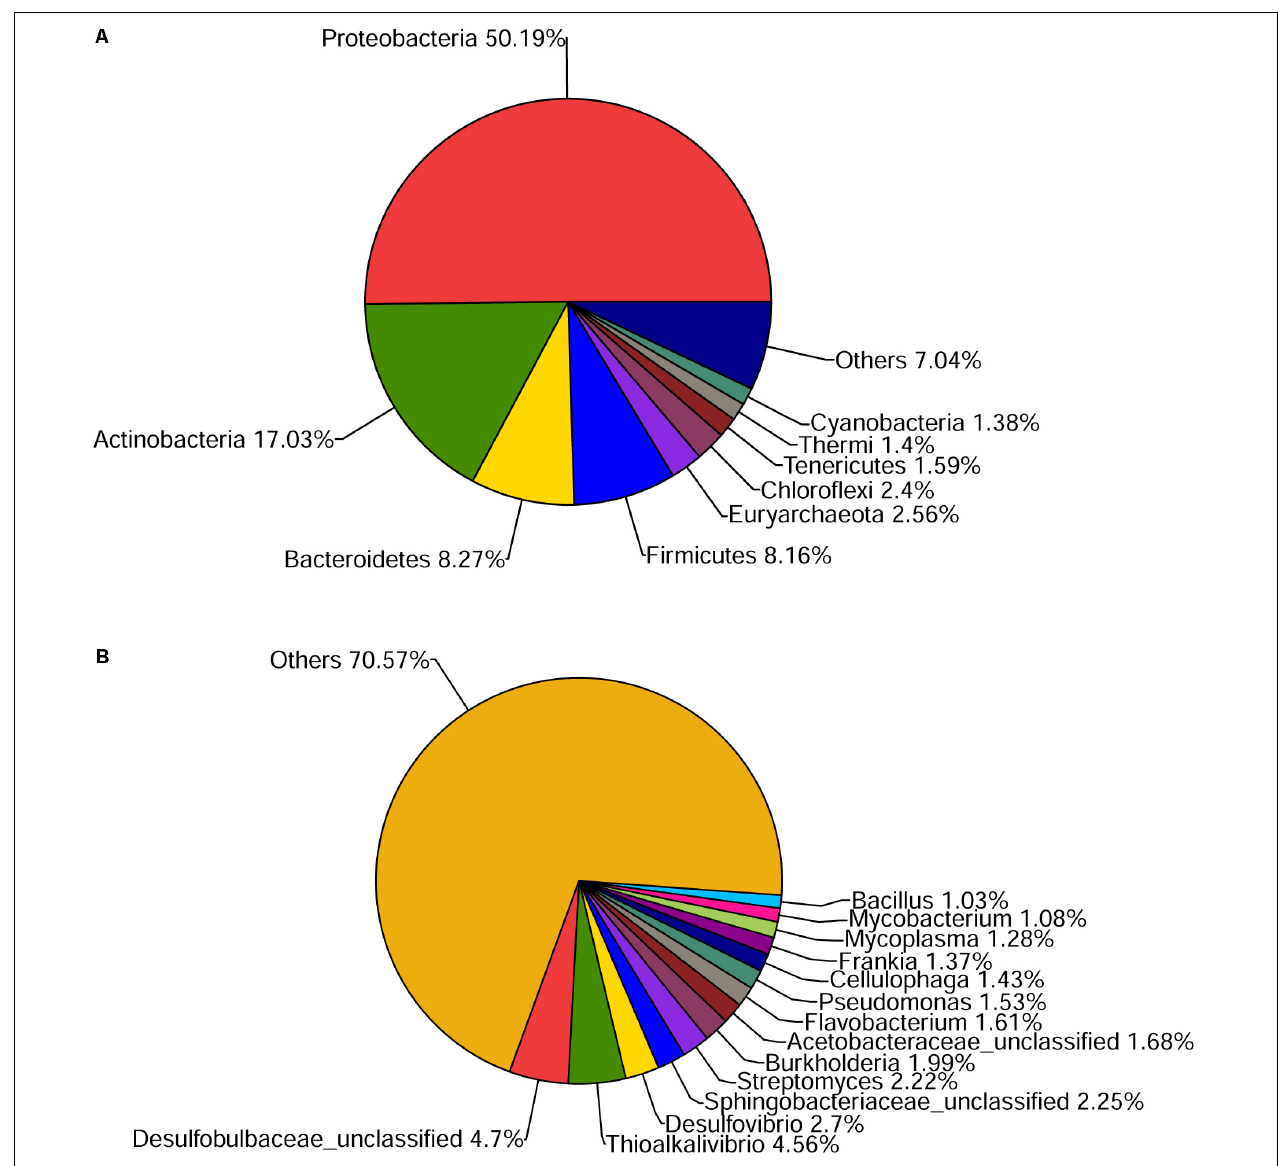
FIGURE 1 | Community composition of mangrove sediment microbiome on phylum (A) and genus level (B) revealed by the SSU rRNA genes in the dataset.